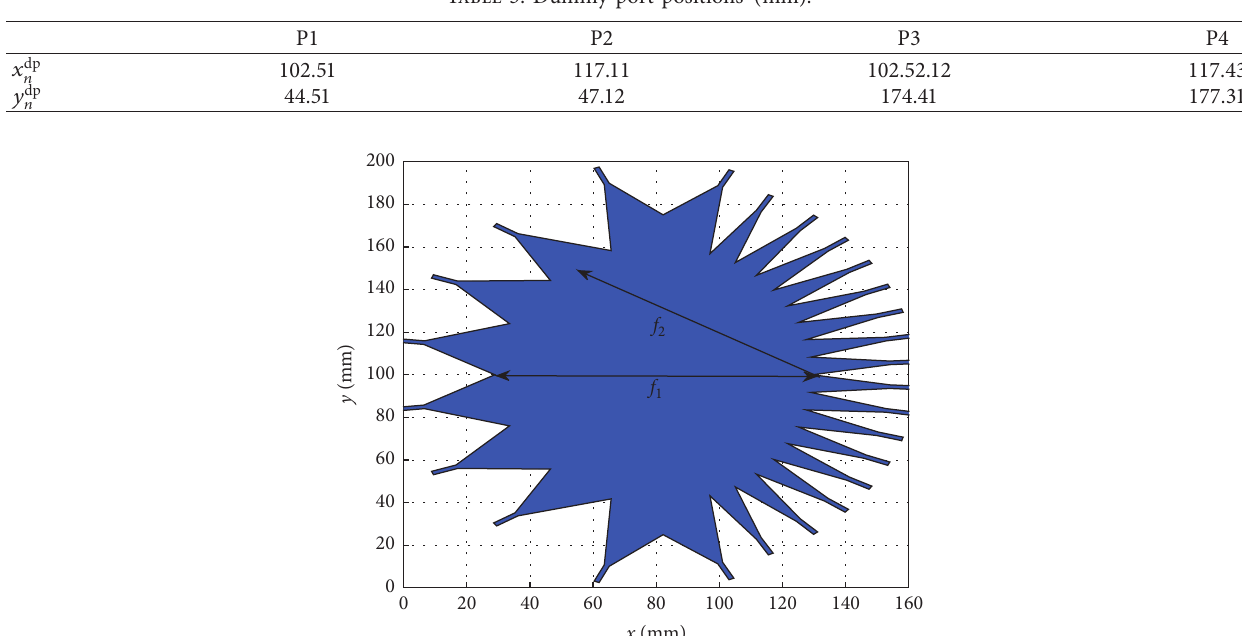
Table 3: Dummy port positions ( mm ) .